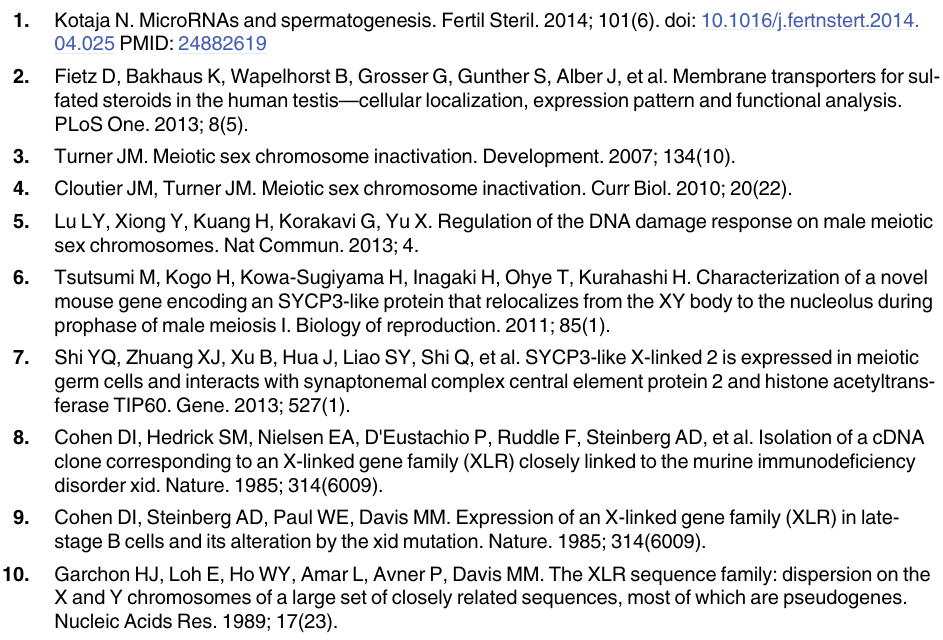
S3 Fig. Genotype analysis of different Slx2 F1 mice. A) Sequencing results of F1 mice. Blue color showed the sequence of gRNAs; protospacer adjacent motifs (PAM) were labeled with purple color; red color showed the modified sequences information after targeting. -, nucleic acid base deletion. B) Western blot analysis of the expression of SLX2 in different lines of F1 mice. WT, wild-type. The number indicated the line number of mice as showed in A). Liver used as negative control. (TIF) S4 Fig. Detection of apoptotic cells in testis with TUNEL assay. A) Testis sections of 3 weeks old wild-type mice. B) Testis sections of 3 weeks old Slx2 knockout mice. Green indicates TUNEL signal. Blue indicates DAPI signal.